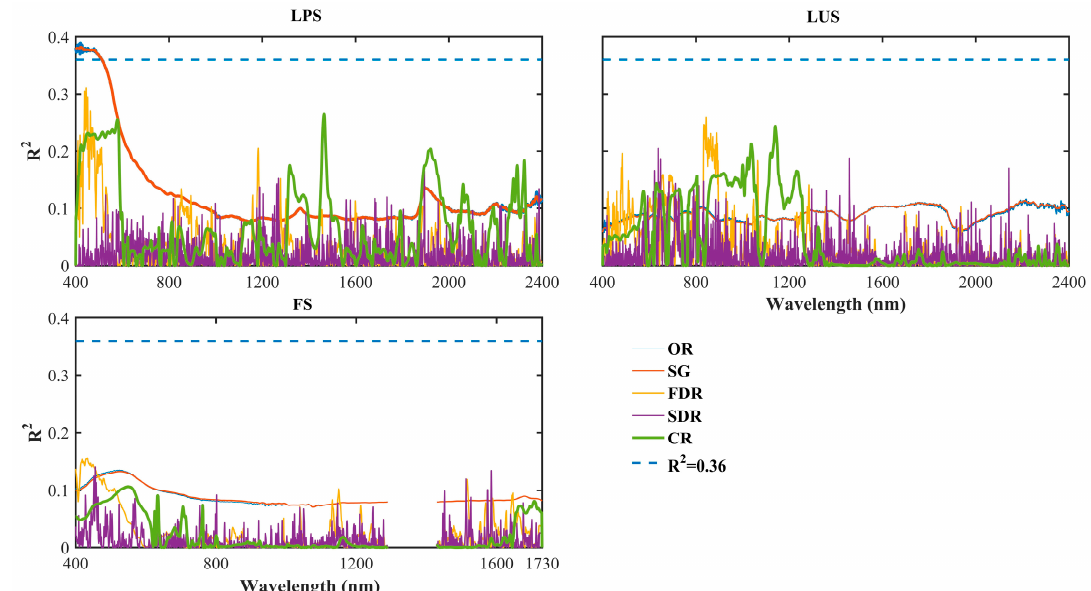
Figure 6. R 2 between Fe content and different spectral reflectance in terms of OR, SG, FDR, SDR, and CR under three experimental conditions.